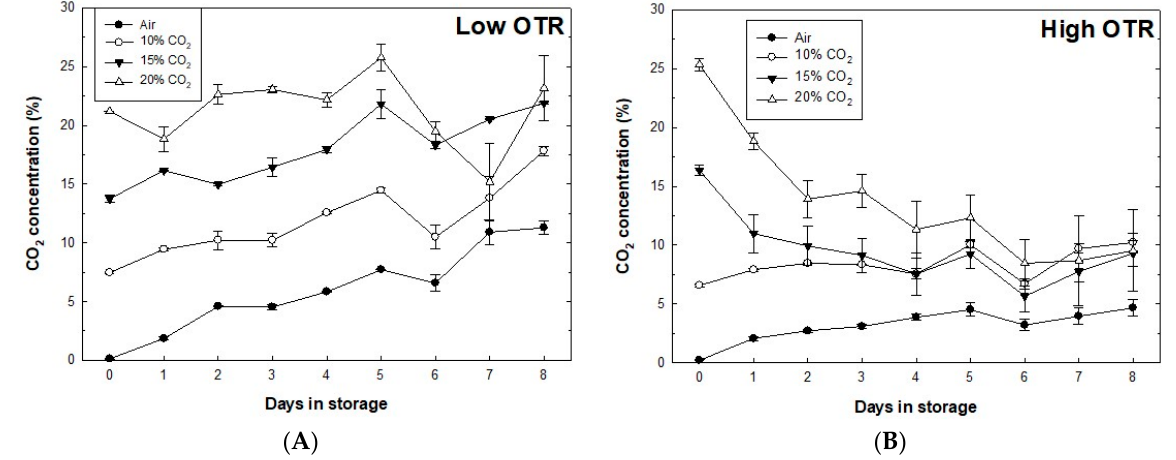
Figure 5. CO 2 concentrations in active MAP of high CO 2 (10%, 15%, and 20%) with low-OTR films ( A ) and high-OTR films ( B ) containing ‘Pione’ grapes during active MAP storage at 10 °C for 8 days. Vertical lines represent the standard error of the mean ( n = 3).